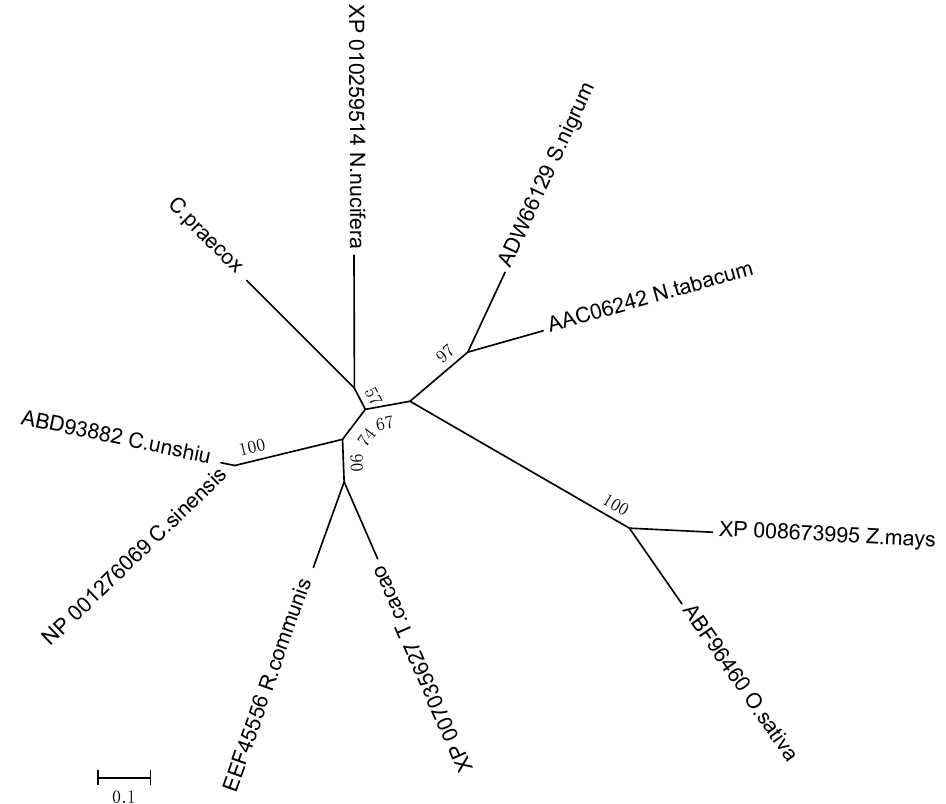
Figure 1. Phylogenetic relationships of CpLEA5 and LEA5 from representative species. A neighbor-jointing tree was constructed using the MEGA6 program. Bootstrap values are shown at the branch points as percentages from 1000 replications. The estimated genetic distance between sequences is proportional to the lengths of the horizontal lines connecting one sequence to another. The protein accession numbers of all LEA proteins are followed by their species names. C. praecox , Chimonanthus praecox ; T. cacao , Theobroma cacao ; R. communis , Ricinus communis ; C. sinensis ; Citrus sinensis ; C. unshiu ,